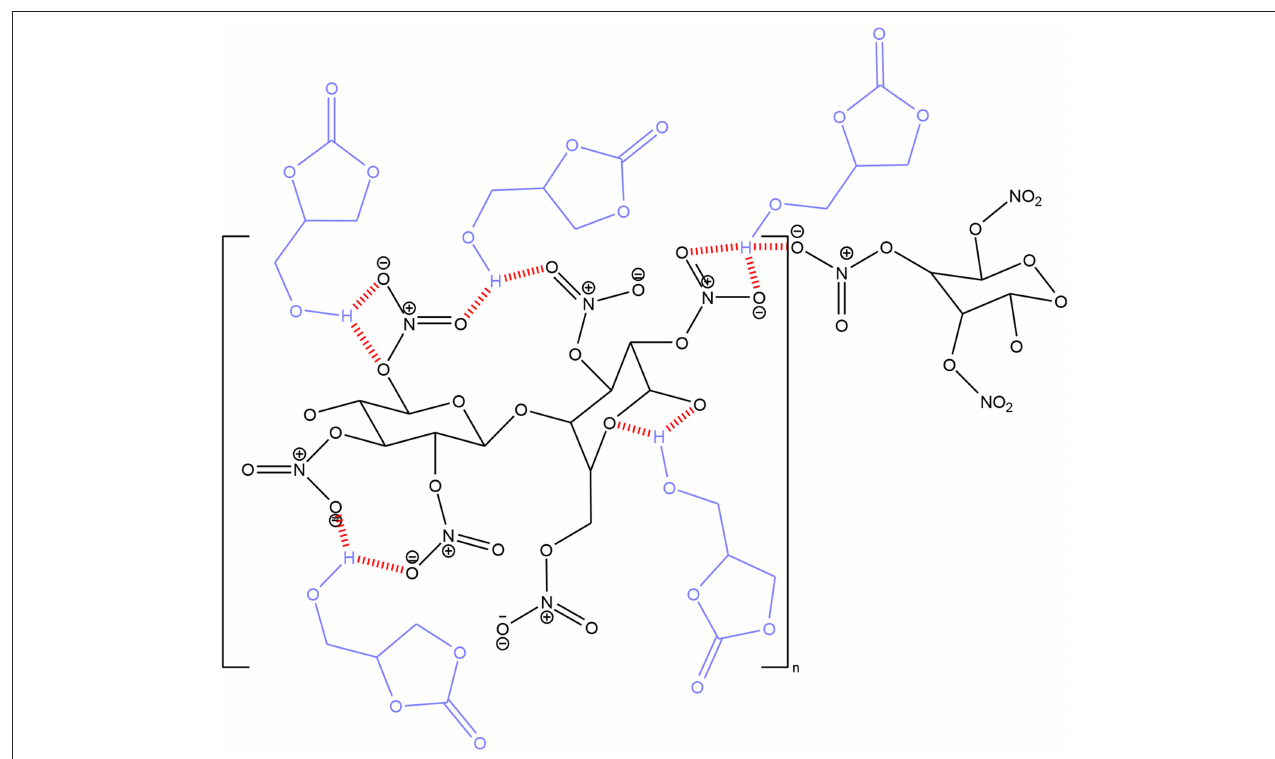
FIGURE 11 | Arrangement of glycerol carbonate molecules within nitrocellulose